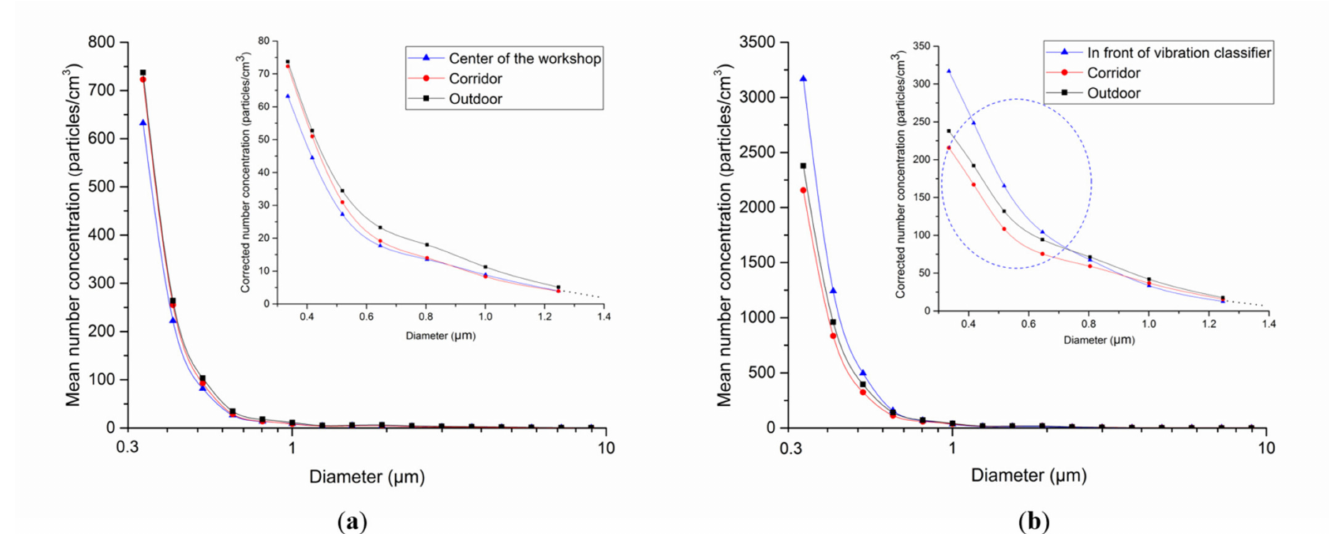
Figure 3. Mean particle size distribution measured by OPS in the first and third days according to measurement points. ( a ) First day, ( b ) third day; the seven size-channels covering the particle sizes of 0.33–1.25 µ m are zoomed to enhance the graph readability after dividing the 0.33, 0.42, 0.52, 0.65 and 0.47 µ m particle number concentration (PNC) size-channels (y axis) by 10, 5, 3, 1.5 and 1, respectively